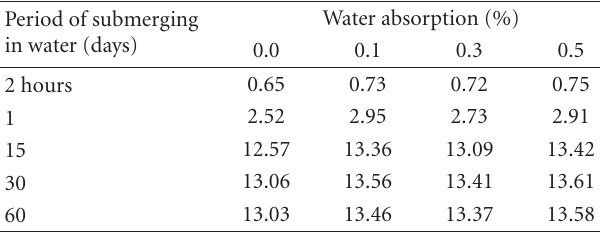
Table 2: Water absorption rate of counterrotating twin-screw extruder.